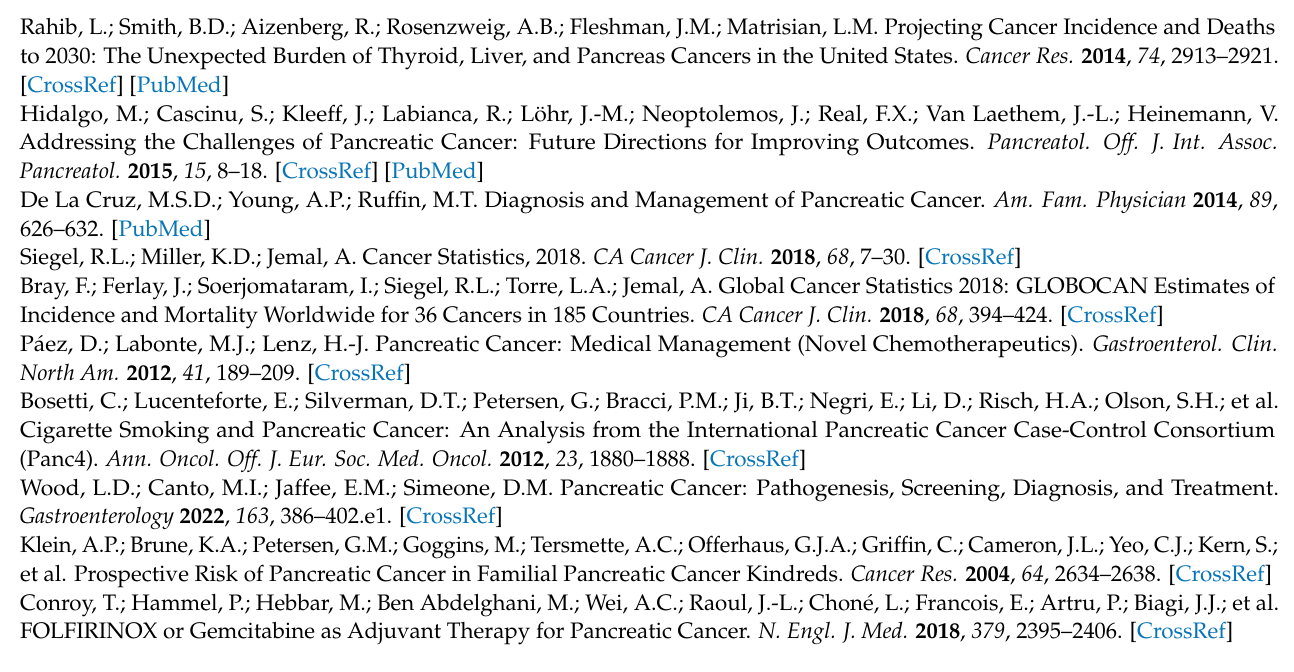
set up the box for docking studies; Figure S4: (A) Schematic representation of the three mains in silico steps: 1. QPLD, 2. IFD, and 3. MD. (B) The ligand root means square deviation (L- RMSD) and (C) the Protein-Ligand (PL) contacts (hydrogen bonds, HB) plots of ID01 (yellow), ID02-A (red), and ID02-B (green) complexes, throughout 100 ns of MDs. Values are expressed as a percentage of interaction between ligand and the principal residues of the protein during the trajectories. Figure S5: Depiction of the (A) QPLD and (B) IFD docking poses for each complex (ID01, yellow; ID02-A, red; and ID02-B, green). The principal residues and ligands are labelled and shown in stick and ball and stick, while hydrogen bonds are pictured as dashed black lines. Both pocket and ligand surfaces, and the pharmacophore molecular interaction fields of the pocket calculated by SiteMap, are highlighted. The hydrophobic, hydrogen bond donor and/or acceptor areas are coloured in yellow, blue and red, respectively; Figure S6: Comparison of the root mean square deviation (RMSD) plots of the MD of the apo structure (black) with the respect to the hLIF/hLIFR complex (orange) for D1-D5 (left) and D3-D4 (right) domains; Figure S7: MIA PaCa-2 cells were serum starved and challenged with vehicle or LIF (10 ng/ml) alone or in combination with mifepristone (10 µ M) for 24 h. The map shows the pathway main regulated by mifepristone action. The upregulated and genes (Fold Change < − 2 or > 2, p value < 0.05) are represented in the map in